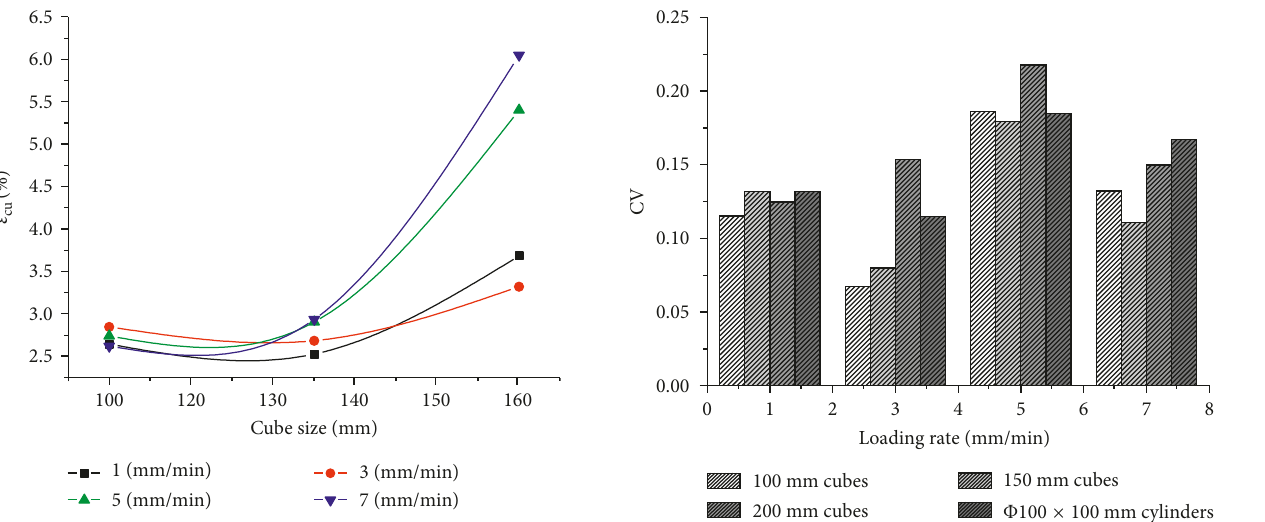
Figure 7: Peak strains of cubes under different loading rates.